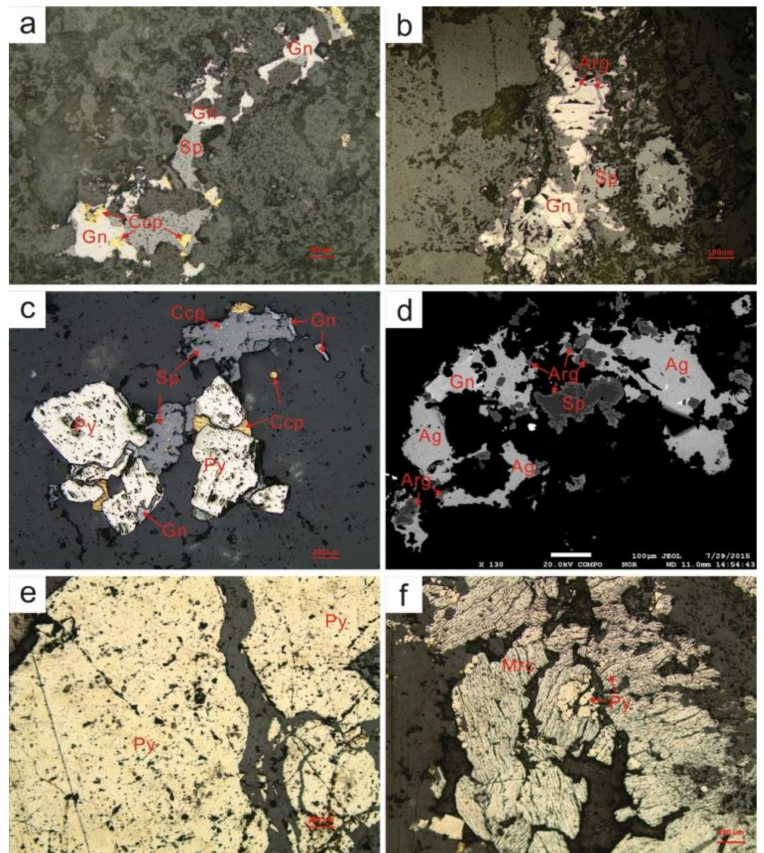
Figure 3. Representative photos of ores from the Yingfang deposit (reflected light, d, is backscattered image). ( a ) The chalcopyrite is contained in the late galena sphalerite, which metasomatized the sphalerite (200:1); ( b ) The sphalerite metasomatized galena and the pyroxene distributed in galena along the fracture (100:1); ( c ) Galena and sphalerite metasomatized the earliest pyrite, chalcopyrite dissolved in sphalerite (50:1); ( d ) Pyroxene metasomatism sphalerite, metasomatism edge formed in sphalerite, galena metasomatism natural silver (100:1); ( e ) Pyrite is cataclastic due to dynamic metamorphism (50:1); ( f ) The cut surface of marcasite is striped, and marcasite is interbedded with pyrite (50:1). Ccp, chalcopyrite; Gn, galena; Py-pyrite; Sp, sphalerite; Arg, argentite; Mrc,